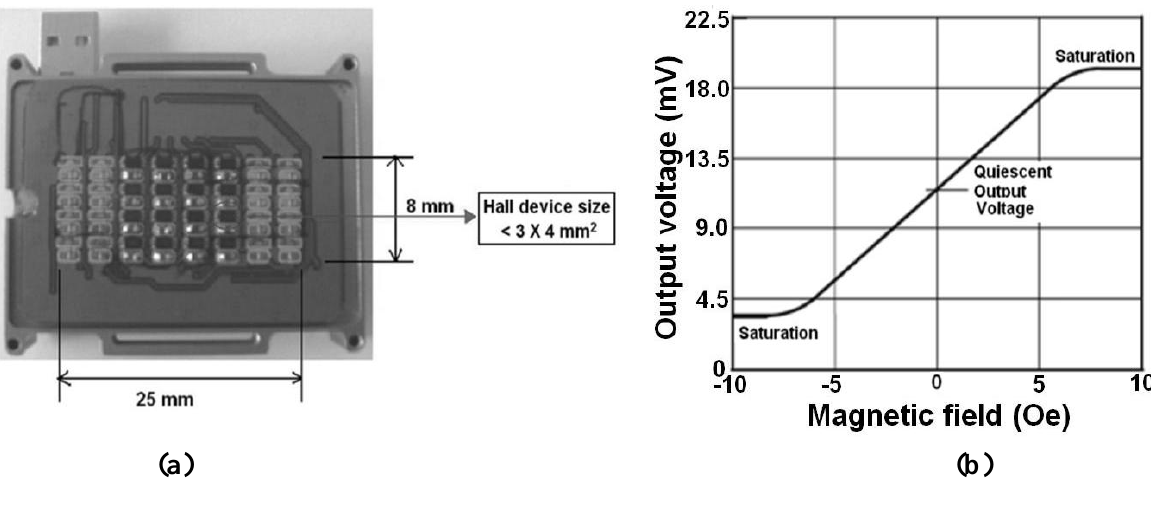
Figure 2. (a) PCB pulse-sensing component mounted with a multiple 5 × 9 = 45 array of Hall devices corresponding to the permanent magnets underneath. (b) A graph of output voltage versus magnetic field for the commercial, A3515-and A3516-type Hall device showing high sensitivity of 1.2 mV/Oe and linearity in the magnetic field and temperature range from −5 Oe to +5 Oe and from −40 °C, to +150 °C,